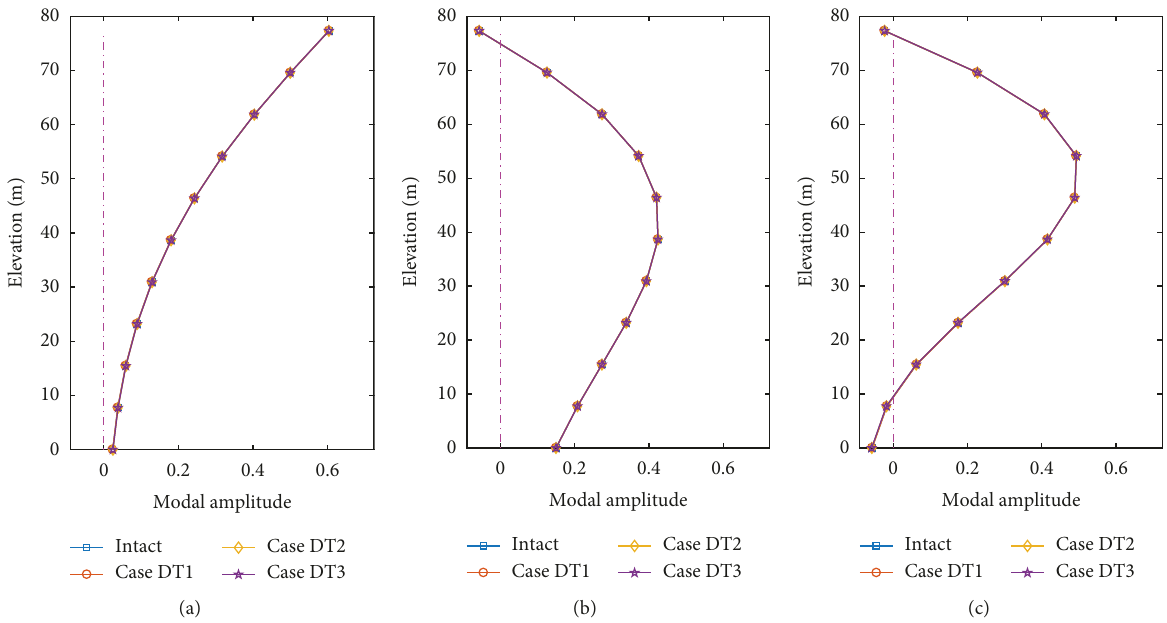
Figure 16: Across-wave bending mode shapes: damage type 1. (a) Mode By1. (b) Mode By2. (c) Mode